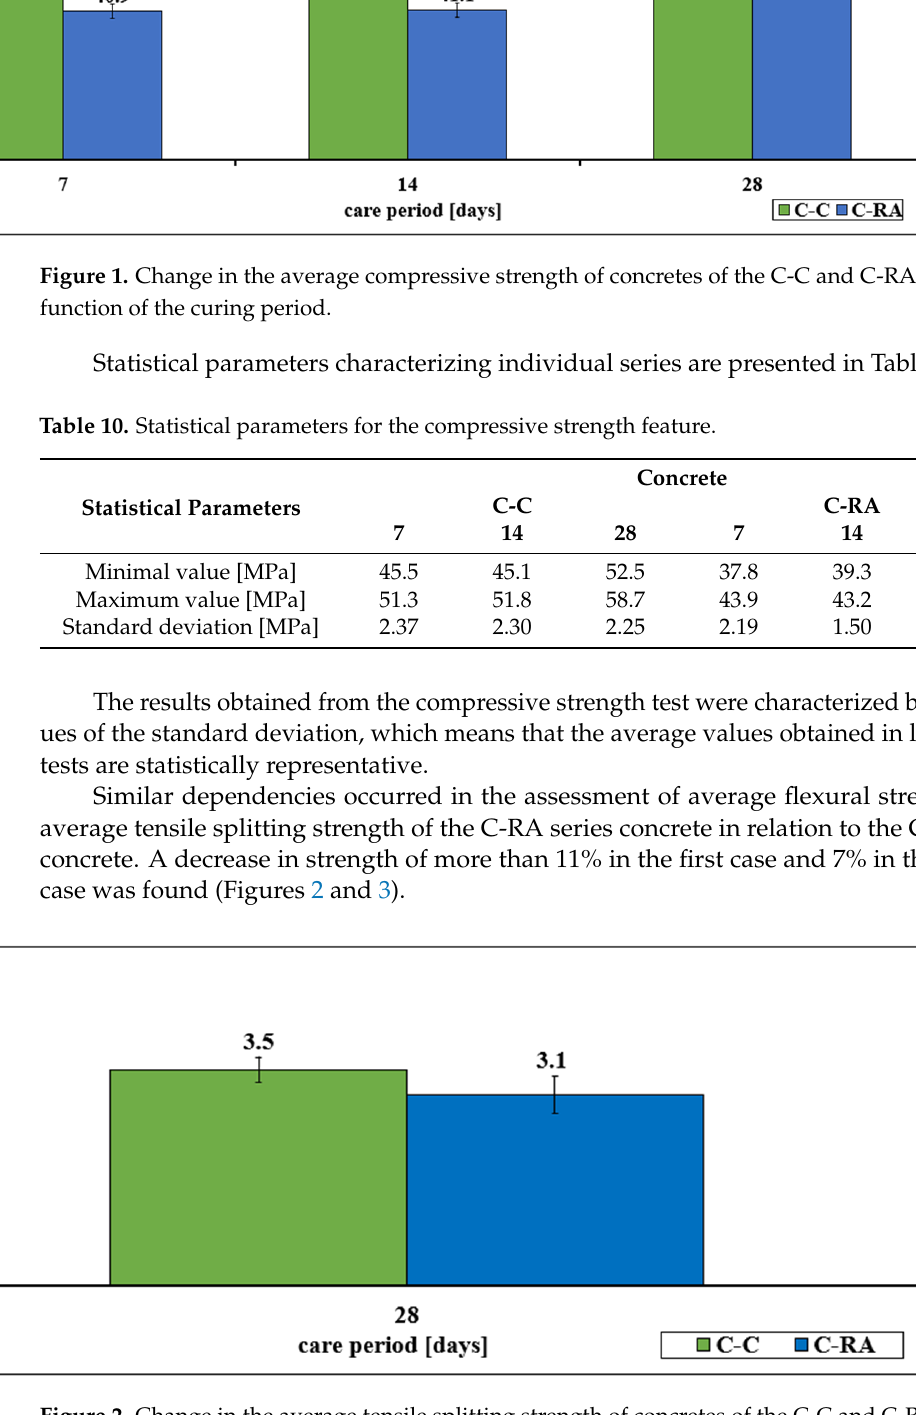
Figure 2. Change in the average tensile splitting strength of concretes of the C-C and C-RA series.